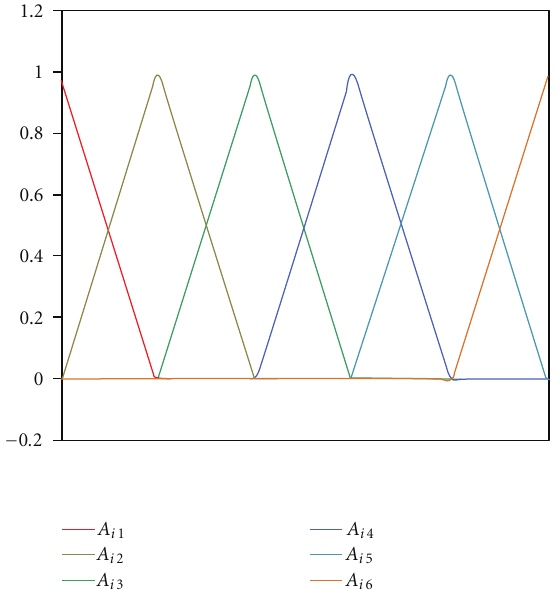
Figure 10: Inclusion areas for the fuzzy association rule R 3.